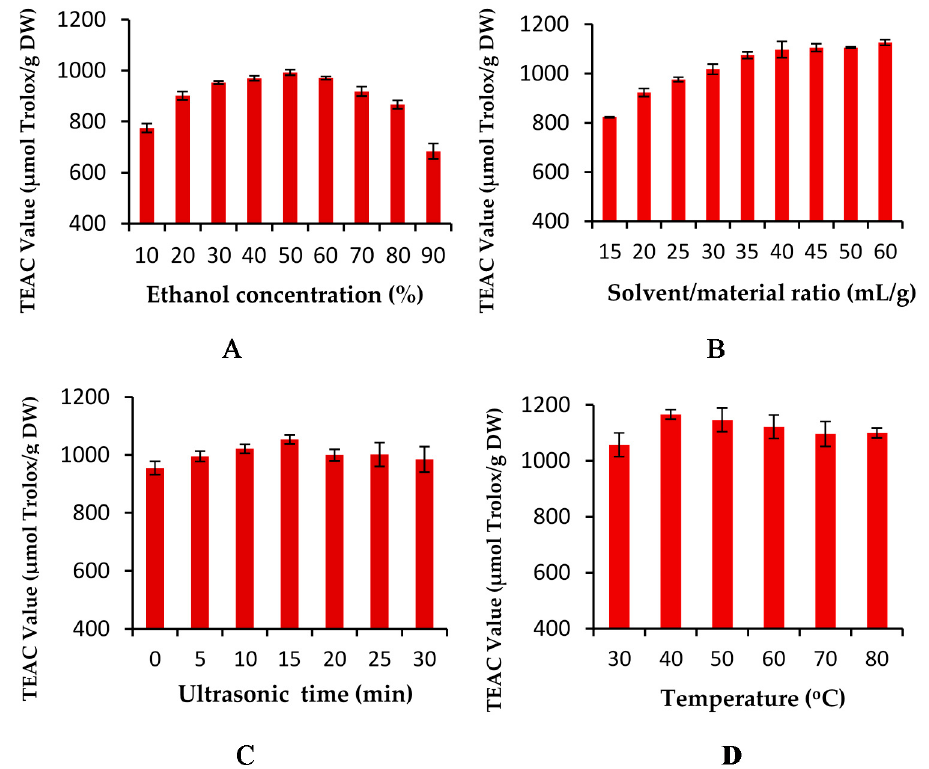
Figure 1. Effects of extraction parameters on the antioxidant activities of flower extracts: ( A ) Effect of ethanol concentration on the antioxidant activities; ( B ) Effect of the solvent/material ratio on the antioxidant activities; ( C ) Effect of ultrasound irradiation time on the antioxidant activities; and ( D ) Effect of temperature on the antioxidant activities.